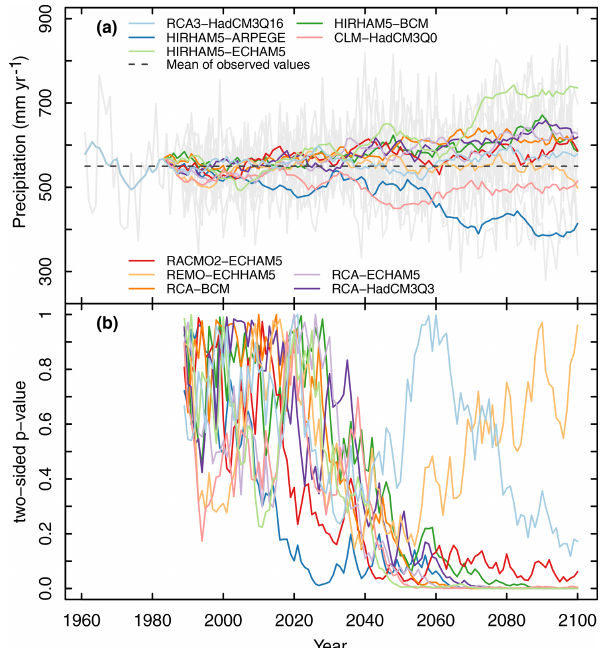
Figure 6. (a) Annual precipitation rates of 10 climate simula- tions with different models for the station Geisenheim (Rheingau), Germany, for the emission scenario RCP8.5. Grey lines show the range of annual values of all models, coloured lines 11-year run- ning means for individual model runs. The period from 1961–1988 shows observed data. The (b) p values calculated with Mann– Kendall trend test for time series of annual precipitation rates shown in (a) starting in